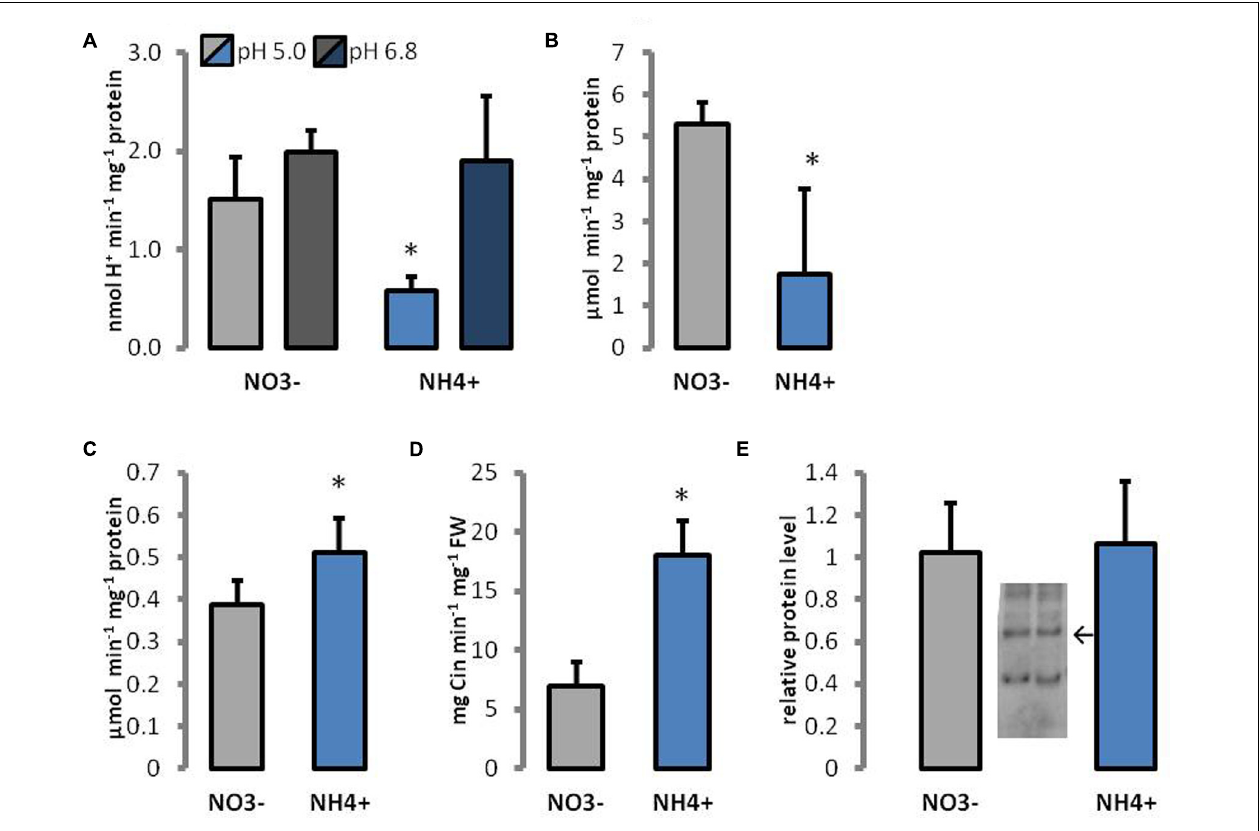
FIGURE 7 | Enzymes engaged in cell wall metabolism of plants growing on NH 4 + and NO 3 − (control). The activity of (A) pectin methylesterases, (B) polygalacturonases, (C) cell wall peroxidases, and (D) phenylalanine ammonia lyases, in leaf tissues, and (E) the protein level of xyloglucan endotransglycosylases; arrow indicates the band representing 33 kDa specific for XTH/XET. Signal intensities of bands were estimated using Image-Lab 5.2 software. Representative results from four independent biological replicates are